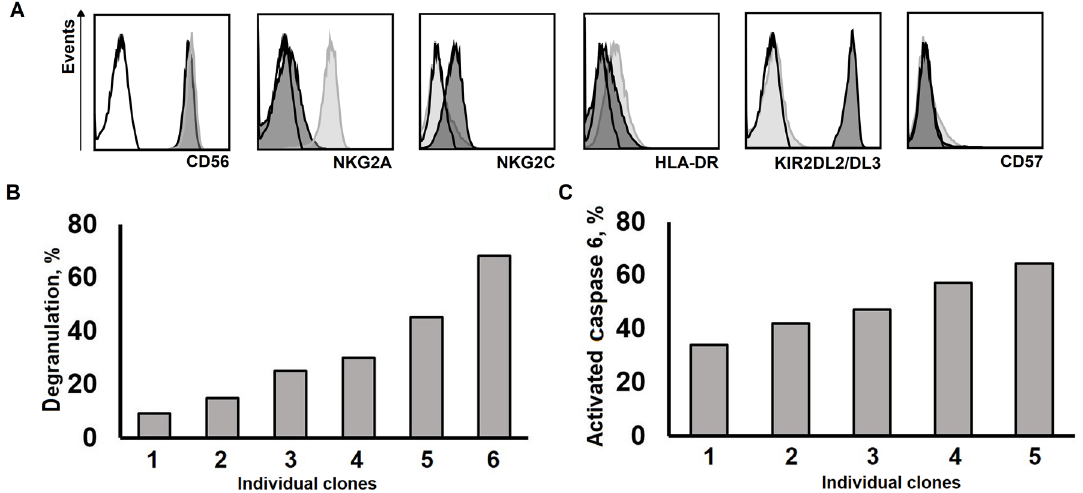
Figure 5. Analysis of the phenotype and functional activity of long-lived NK cell clones. ( A ) Phenotypic analysis of NK cells clones performed at week 10 of culturing. Two phenotypic patterns (light grey and dark grey) are shown. ( B ) Degranulation of the clones, measured by the level CD107a expression on the cell surface after incubation in the presence of K562 target cells at week 14 of cultivation. ( C ) The efficacy of natural cytotoxicity of the clones, measured by caspase-6 activation in K562 target cells at week 14 of